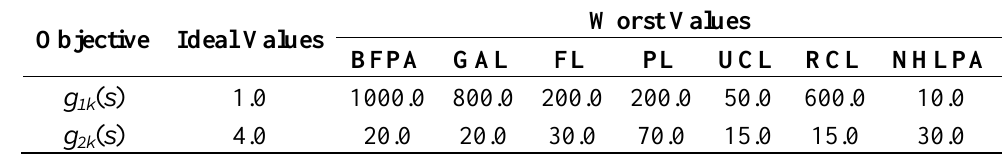
Table 3. The extreme fitness values of spatial compactness